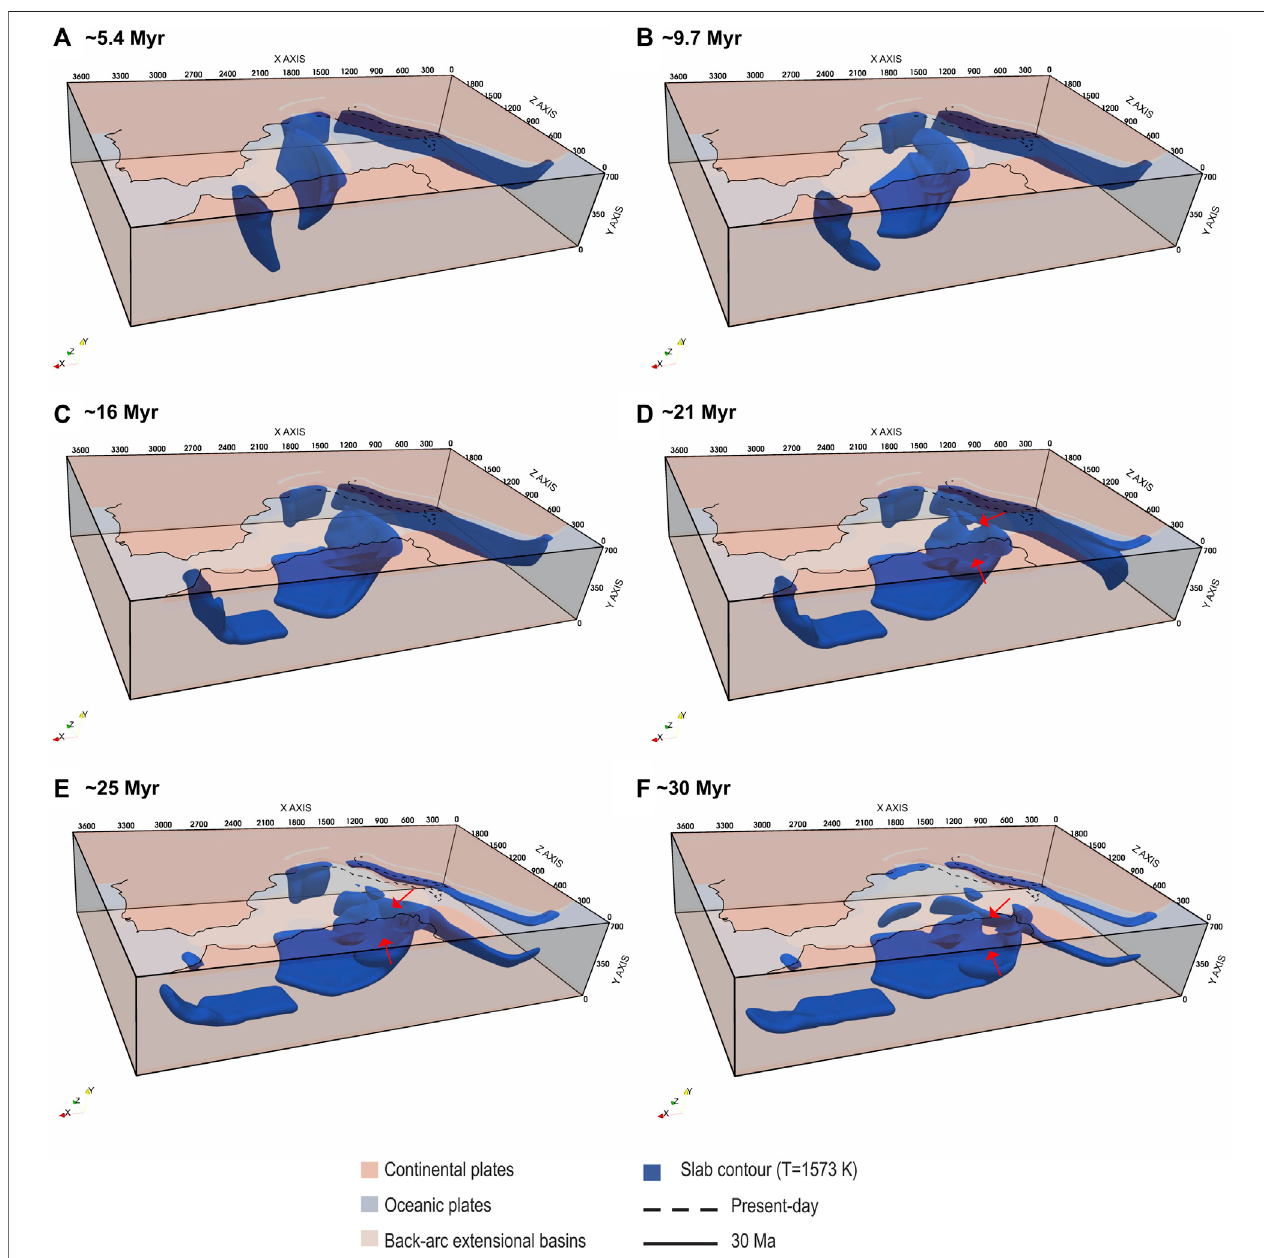
FIGURE 5 | Snapshots of the Model CWM geodynamic evolution at (A) ~5.4 Myr, (B) ~9.7 Myr, (C) ~16 Myr, (D) ~21 Myr, (E) ~25 Myr, (F) ~30 Myr. In blue the subducted. Snapshots of the Model CWM geodynamic evolution. In blue the subducted slabs (contour at T=1573 K) below ~100 km depth. The plates are partially transparentforabettervisualizationofthesubductedslabs.ThesolidblacklineindicatesthecoastlinesintheOligocene-Miocene(vanHinsbergenetal.,2014),whilethe dashed black line indicates the present-day coastlines of peninsular Italy. The red arrows indicate the two slab windows beneath the Central Apennines and the Africa continental plate.